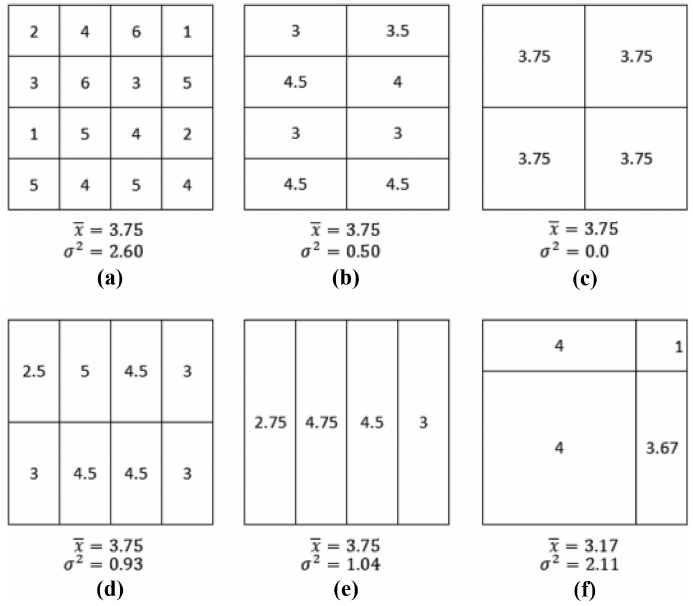
Figure 1. (a – c) Scale effect. As scale of aggregation increases, mean